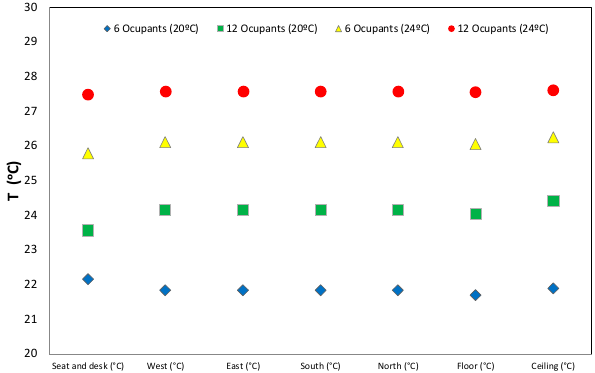
Figure 4. Surrounding surfaces temperatures used in the CFD simulation and calculated by the building thermal behavior (BTB).